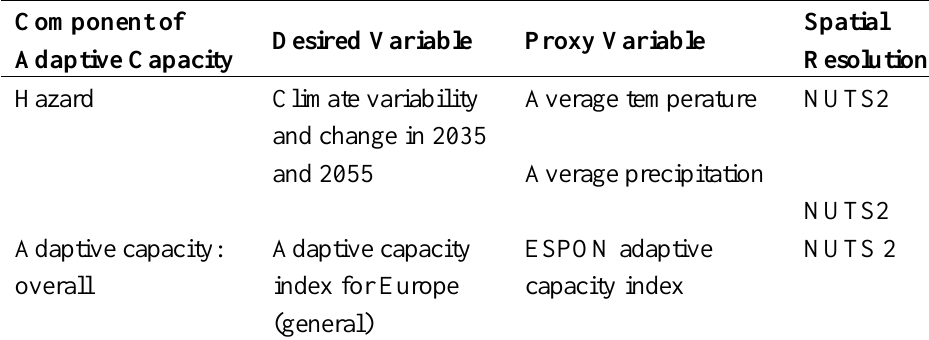
Table 2. Datasets used in the final vulnerability